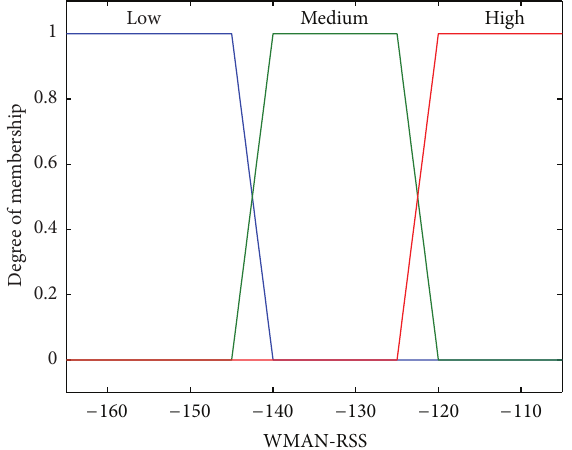
Figure 3: Fuzzy set representing RSS (WMAN).